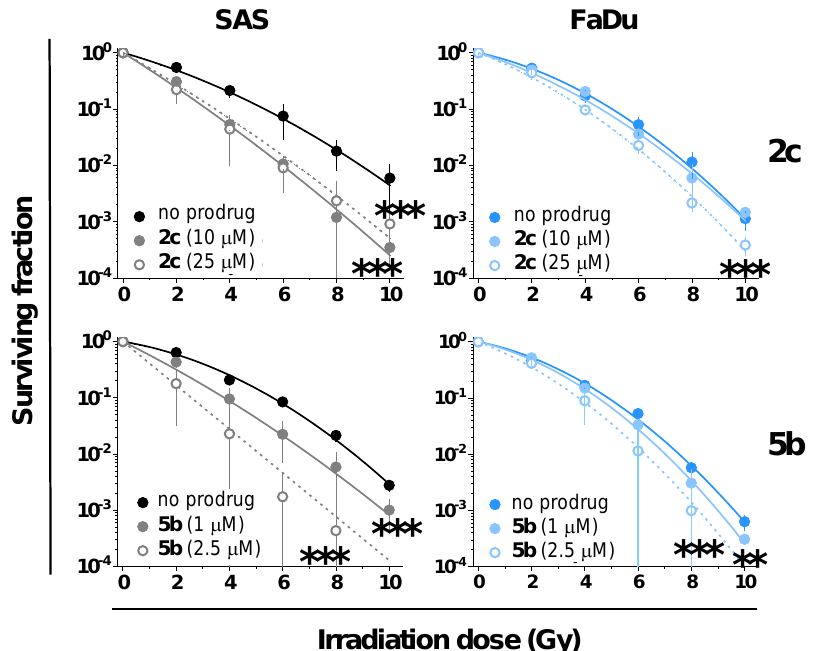
Figure 8. Representative data illustrating the synergy of prodrugs 2c and 5b with radiotherapy in SAS and FaDu cells. The graphs show clonogenic survival as a function of the irradiation dose. The data points represent mean values (±SD) from n = 3 independent experiments and the lines display the clonogenic survival curve fits. ** p < 0.01; *** p < 0.001.